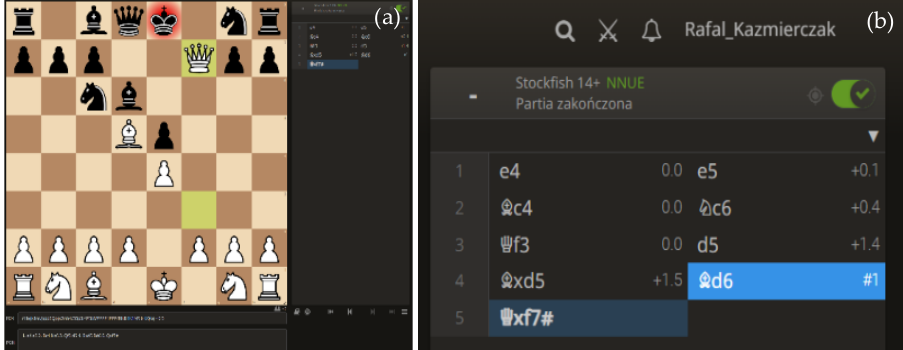
Figure 5. Example of a chess game with move analysis performed by the chess engine: ( a ) current move, ( b ) the record of the game. Source: own study.